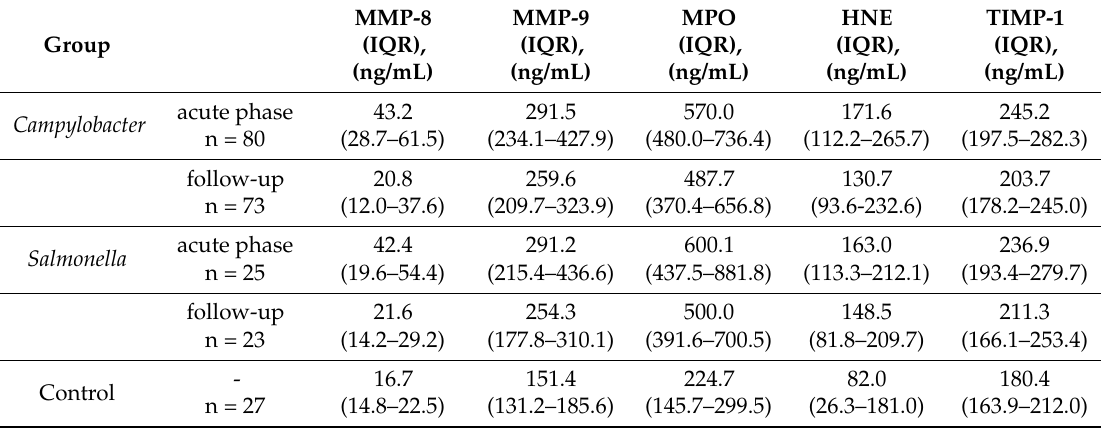
Table 2. Serum concentrations of matrix metalloproteinase (MMP)-8, MMP-9, myeloperoxidase (MPO), human neutrophil elastaste (HNE) and tissue inhibitor of metalloproteinases (TIMP)-1 in 80 Campylobacter and 25 Salmonella patients and 27 healthy controls. Paired samples were available for 73 Campylobacter and 23 Salmonella patients. Values are shown as median (25–75%